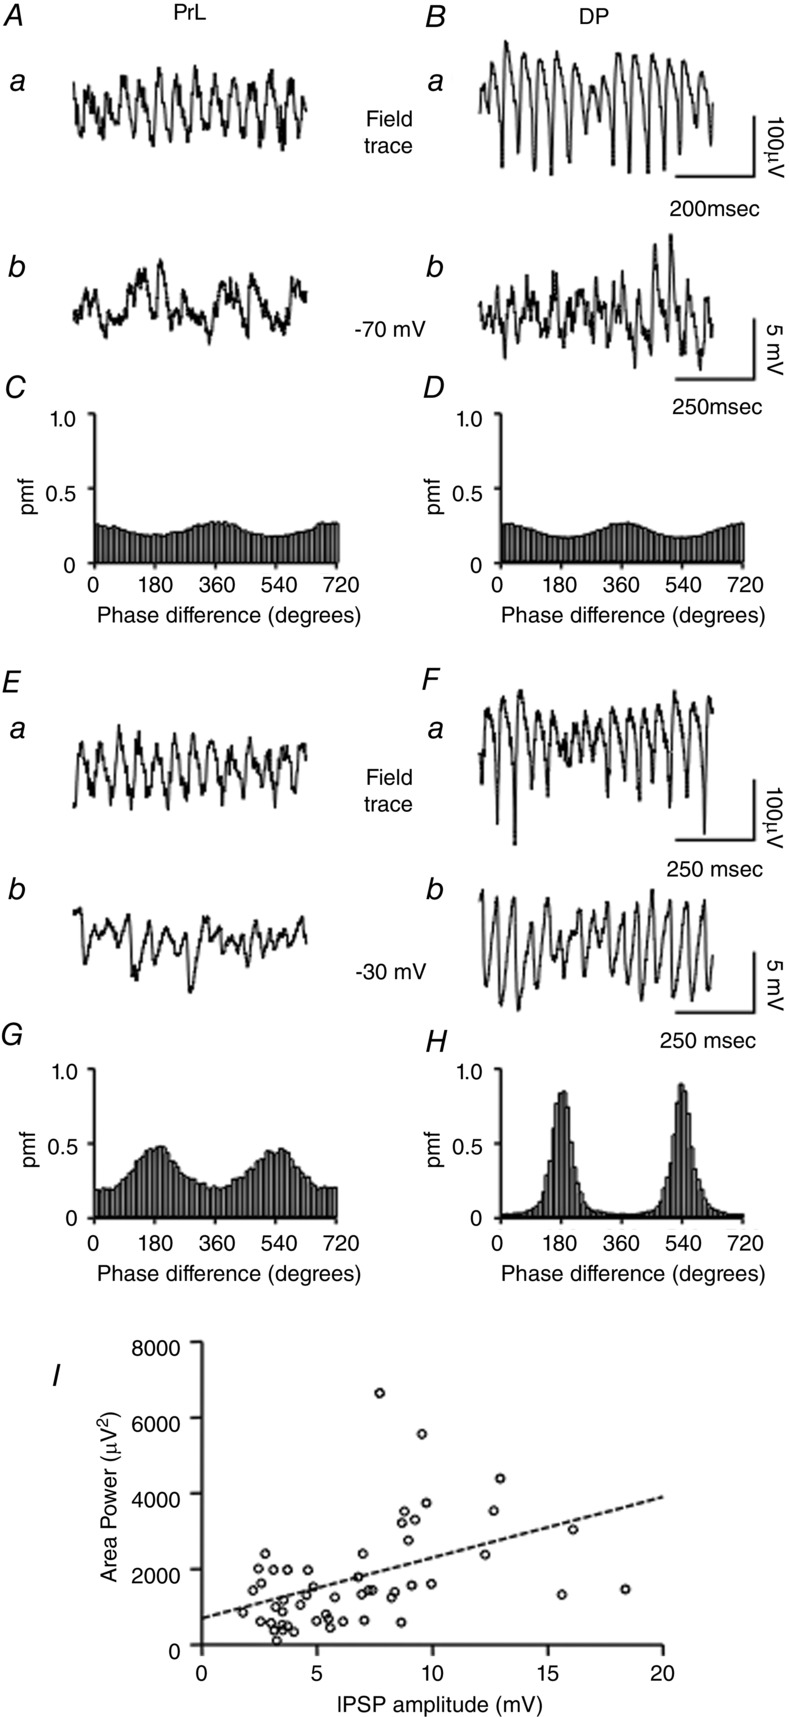
Regional differences of synaptic potentials in the mPFCExamples of extracellular field and synaptic activity recorded from presumed RS cells in PrL (A) and DP (B) during Cb–KA-evoked oscillations. Aa and Ba, 1 s example trace of extracellular field recording. Ab and Bb, 1 s epochs of EPSPs recorded at a membrane potential of −70 mV. Phase coherence histograms (bin size: 10 deg) between field and EPSPs in PrL (C) and DP (D) show low coherence. Different examples of extracellular field and synaptic activity recorded from presumed RS cells in (E) PrL and (F) DP during Cb–KA-evoked oscillations. Ea and Fa, 1 s example trace of extracellular field recording. Eb and Fb, 1 s epochs of IPSPs recorded at a membrane potential of −30 mV. Phase coherence histograms (bin size: 10 deg) between field and IPSPs in PrL (G) and DP (H) show high coherence. I, scatterplot showing a significant relationship between the IPSP amplitude of all mPFC cells (PrL and DP, n = 52) and the area power of the concurrently recorded population field activity; Pearson's product moment correlation (r = 0.45, P < 0.001). Dashed line represents linear regression.